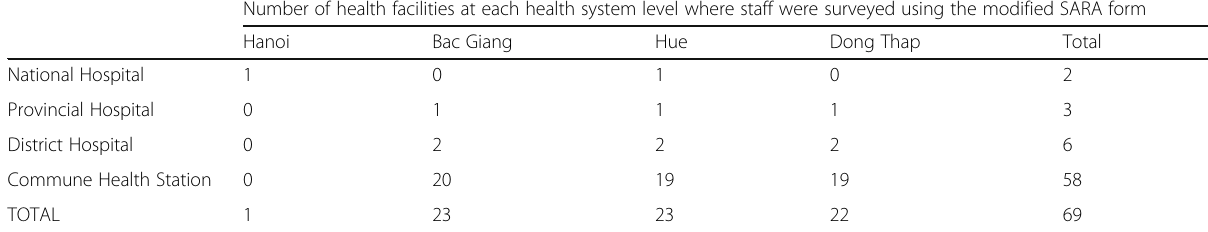
Table 2 Sampling Plan: Number of health facilities at each health system level